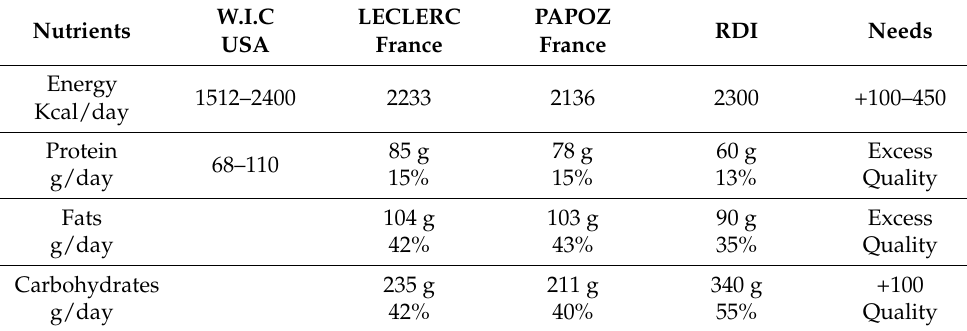
Table 1. Survey and